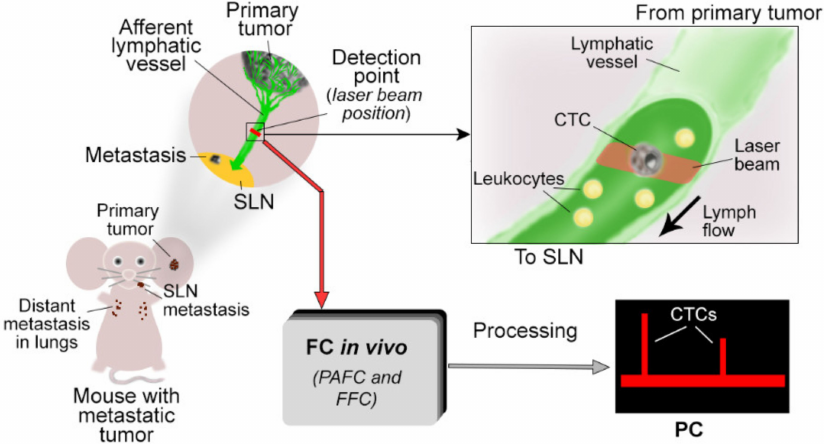
Figure 1. Design of the lymphatics circulating tumor cell (L-CTC0 detection in preclinical animal models of metastatic tumors in